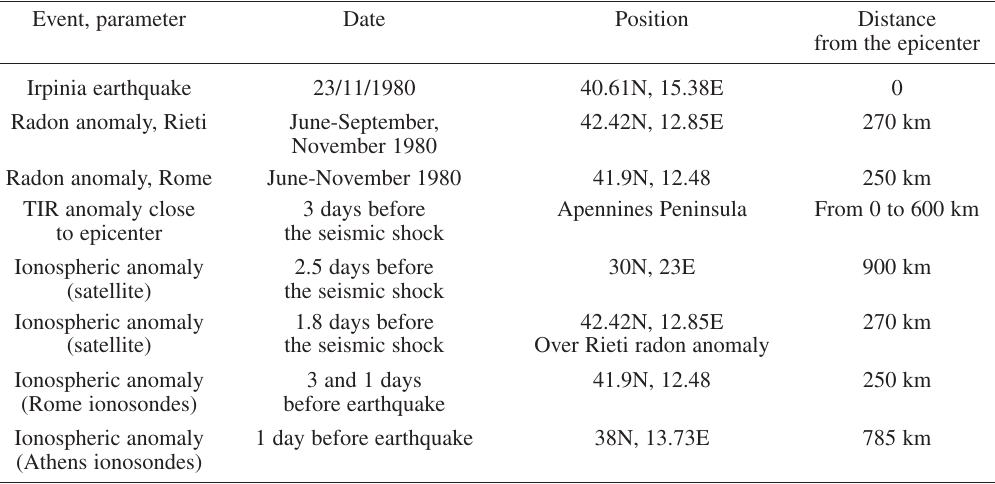
Table I. Spatial and temporal parameters of anomalies registered around the time of Irpinia earthquake. Event,